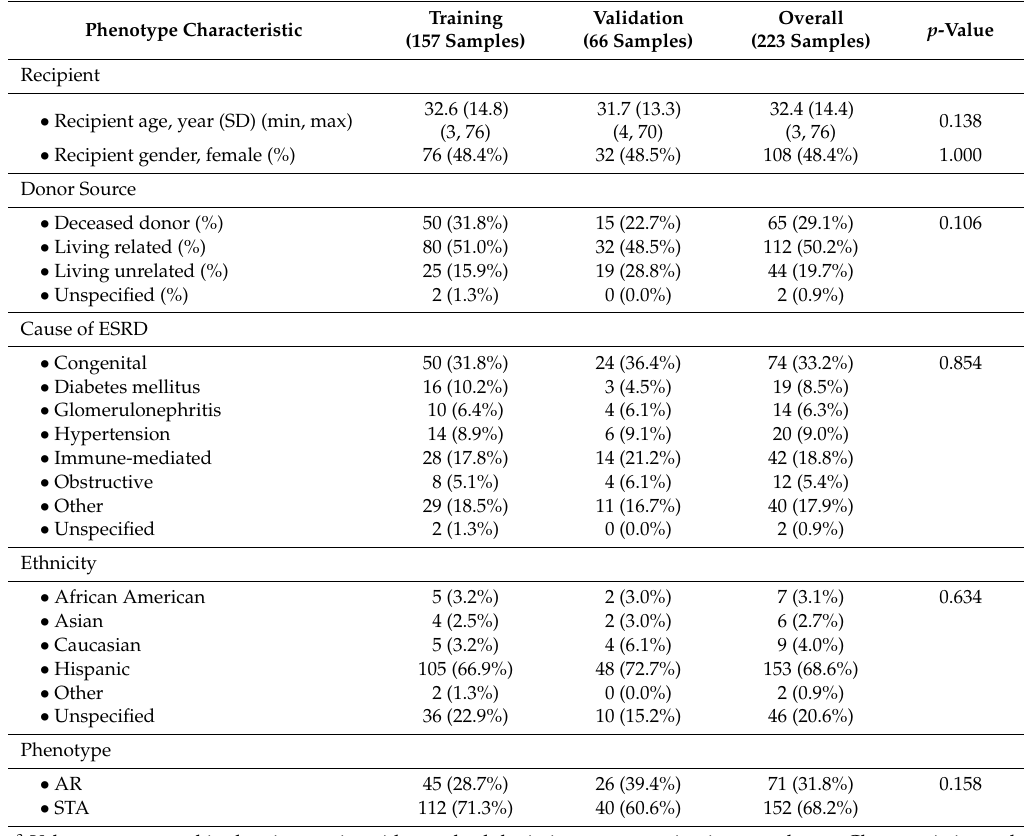
Table 1. Baseline characteristics of study patients.